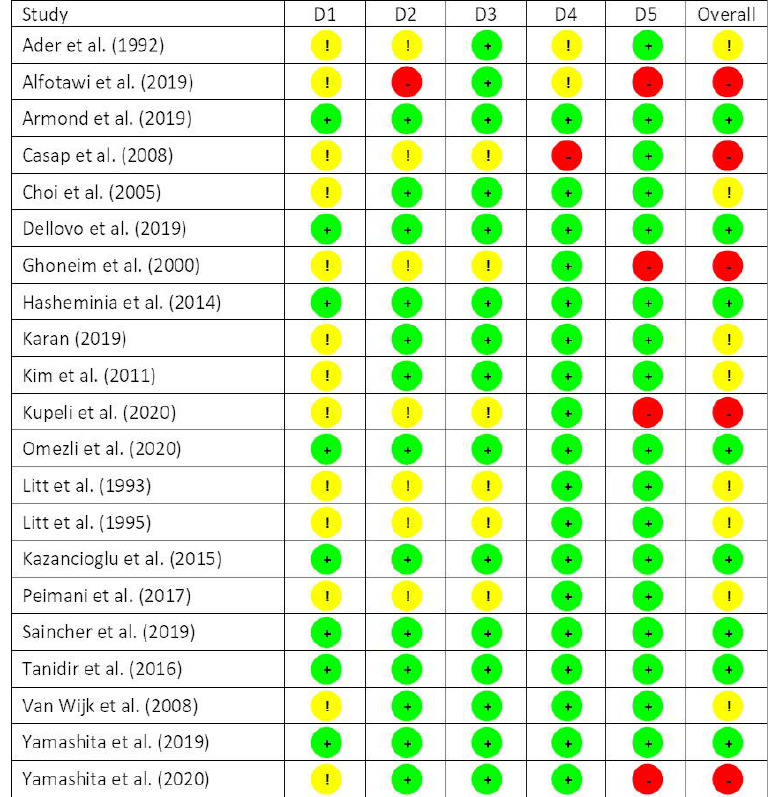
Figure 2. Quality assessment of included studies in a systematic review. Risk-of-bias judgments fall into three categories across five domains, with (+) being of low risk, (!) being of some concern, and (-) being of high risk. The five domains are as follows: (D1) bias arising from the randomization process; (D2) bias due to deviations from intended interventions; (D3) bias due to missing outcome data; (D4) bias in measurement of the outcome; and (D5) bias in the selection of the reported results [13,15,19,31–48].